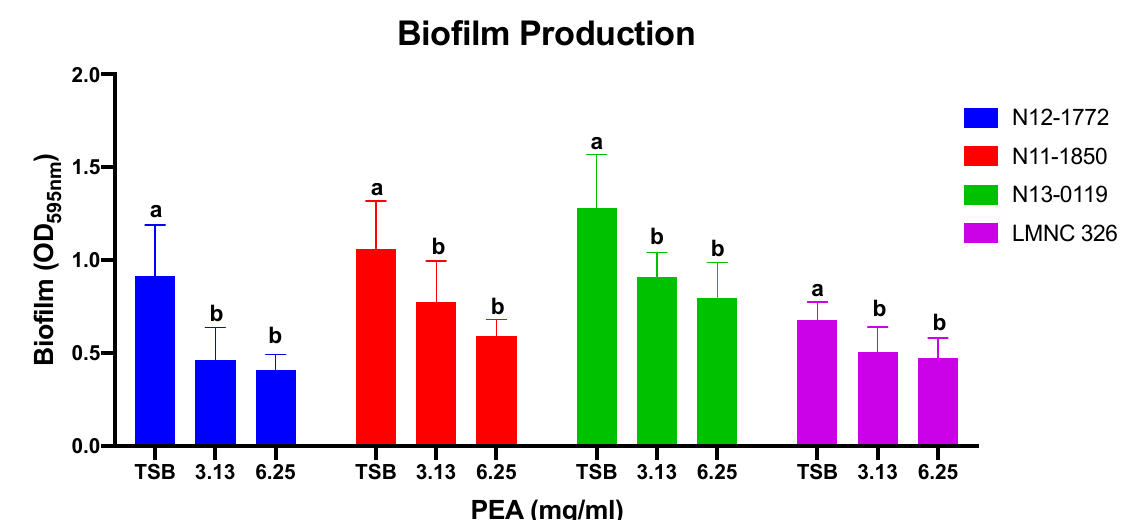
Figure 5. PEA reduces biofilm production. Presented data show the mean (bars) and standard deviation (error bars) of three independent biological experiments for selected strains representing lineage I, II and III. Data for biofilm formation were normalized relative to growth (OD 600nm reading at 96 h). For each strain different letters indicate significant difference between biofilm produced when grown in TSB compared to when grown in TSB supplemented with PEA at sub-MIC concentrations. p < 0.05 based on one-way ANOVA and Tukey post-hoc test pairwise comparison of all the strains.